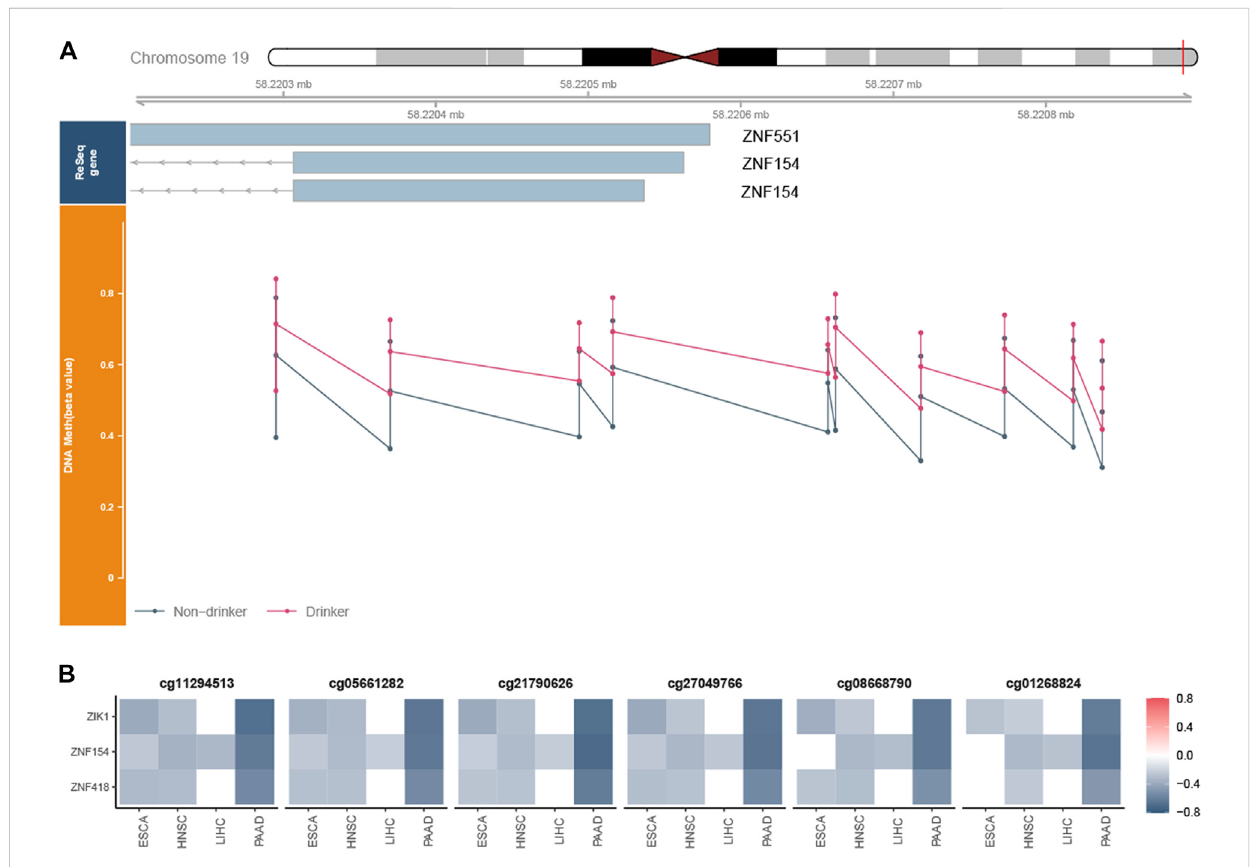
FIGURE 5 Exploration of the CpG island chr19:58220189 – 58220517 . (A) Whole view of CpG probes in the CpG island chr19:58220189 – 58220517 demonstrated its hypermethylation status. The bottom dot plots from left to right represent the beta values of cg1129451, cg0566128, cg21790626, cg27049766, cg03234186, cg08668790, cg12506930, cg26465391, cg01268824, and cg27324426, respectively. cg03142586 was excluded from further analysis since its beta value was NA in most samples. (B) Heatmap revealed the correlation between the beta value of six PDMPs and